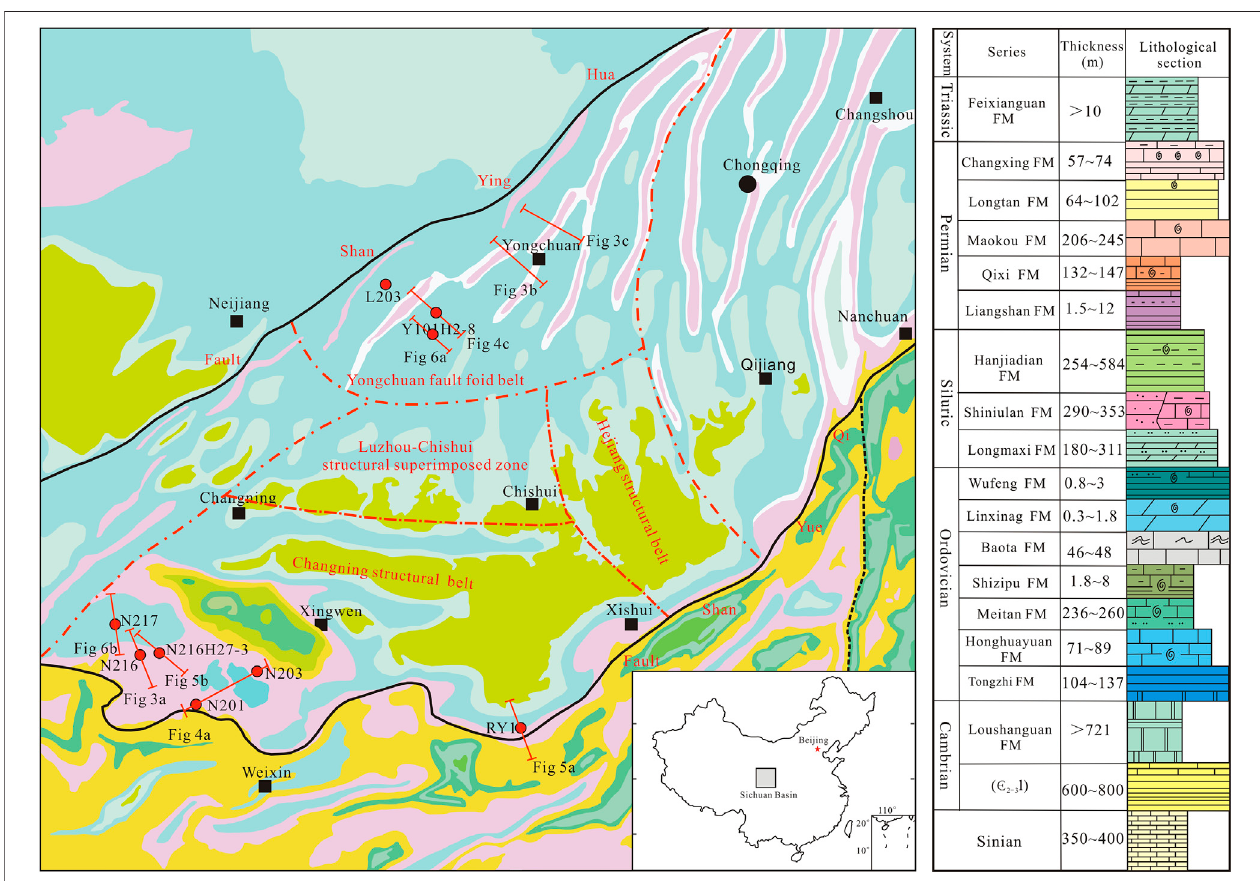
FIGURE 1 | Regional structural location, stratum, and well location distribution in the Sichuan Basin.